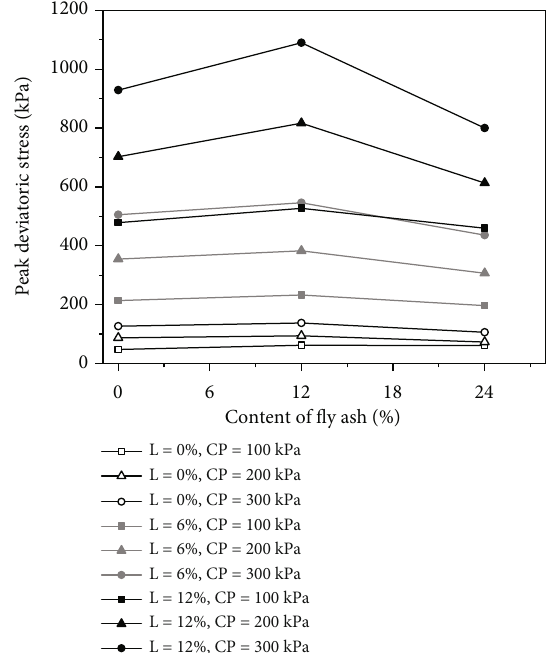
Figure 21: Peak deviatoric stress due to di ff erent content of fl y ash ( FT = 60 ).